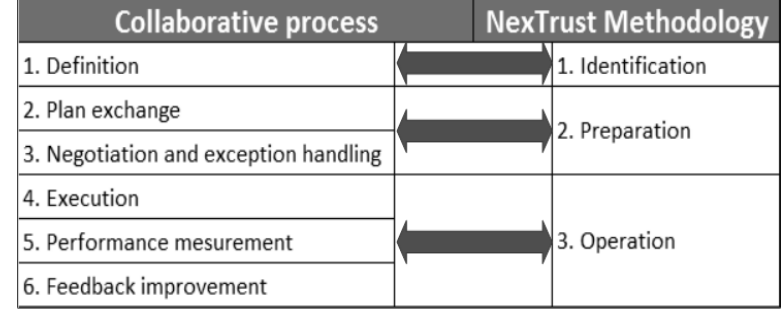
Figure 3. Relationship between collaboration process and NexTrust Methodology.